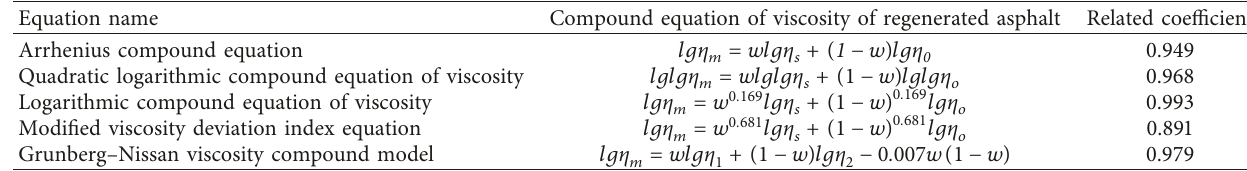
Table 7: Compound equation of rejuvenation viscosity of rejuvenating agent with different models. Equation name